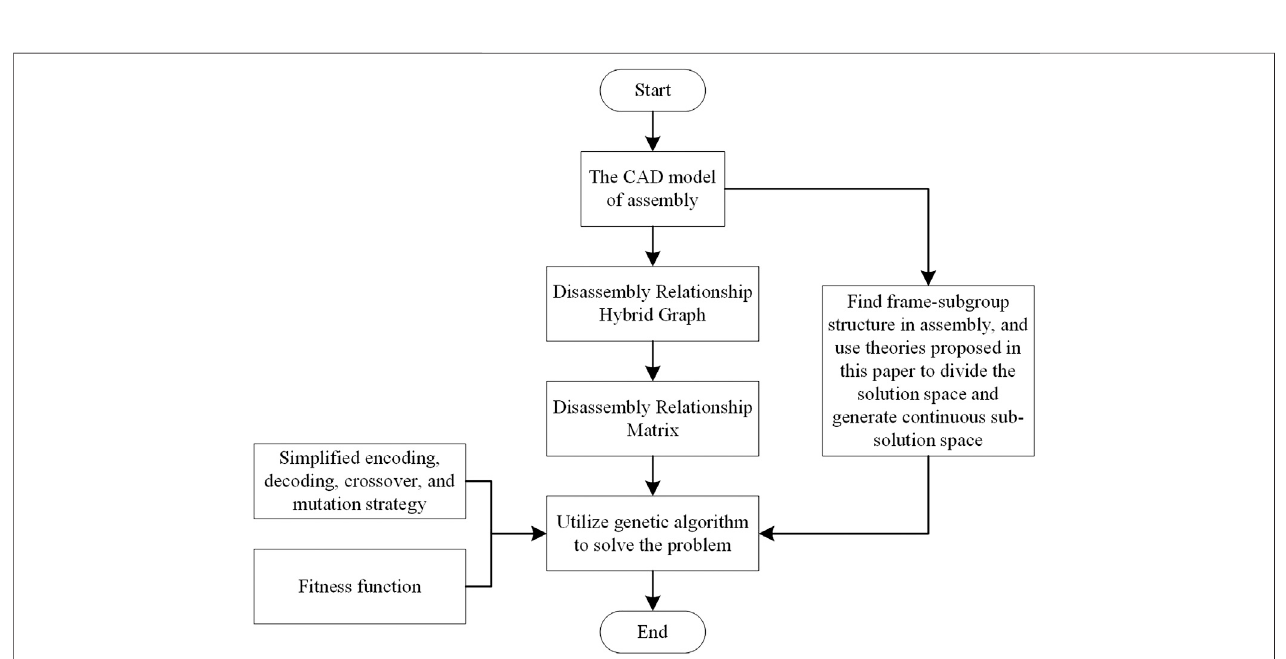
FIGURE 6 | Proposed theoretical model for solving DSP problems.